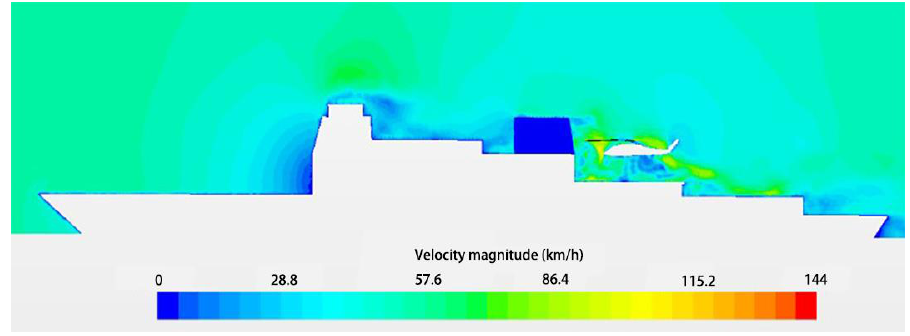
Figure 14. Symmetry plane velocity contour under 0° and 60 km/h WOD condition.